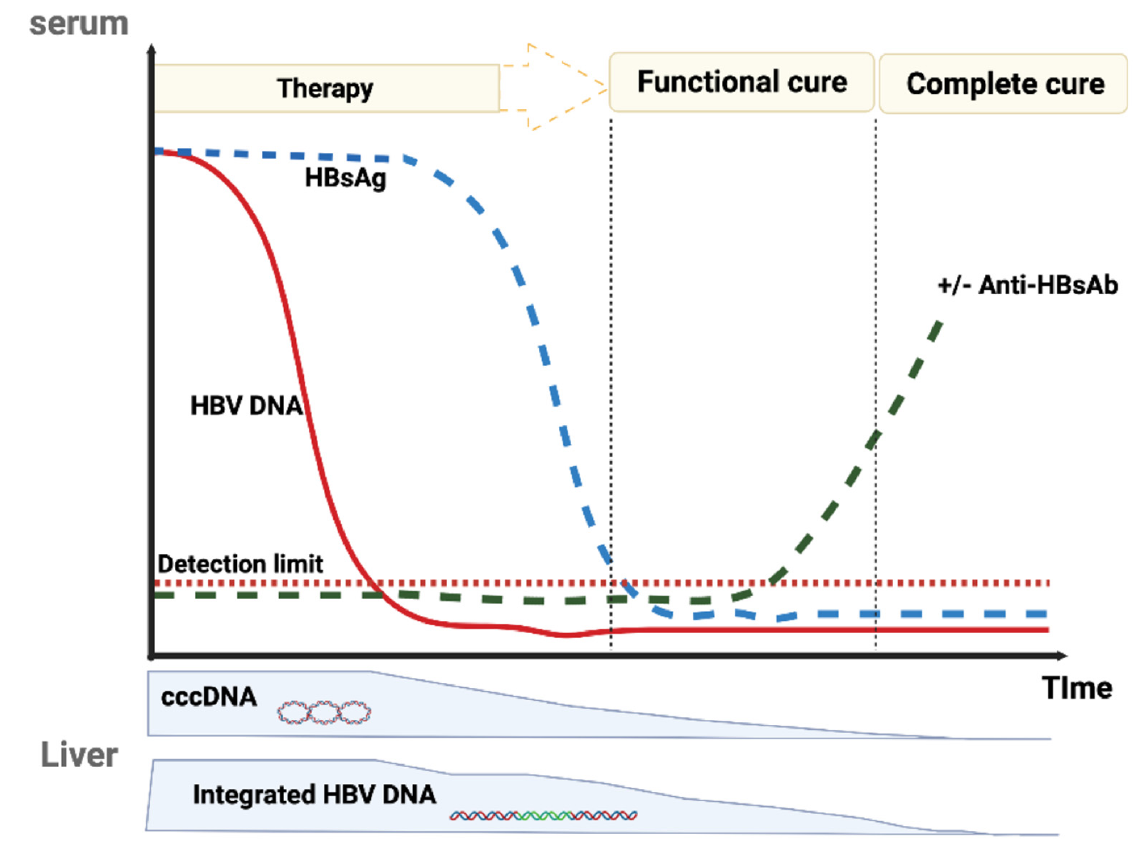
Figure 2. Schematic representation of functional cure and complete cure following antiviral therapy. The HBV DNA, HBsAg, and anti-HBs levels are labeled in red, blue and green dot lines, respec- tively. The detailed definitions of functional cure and complete cure are referred to the main text .